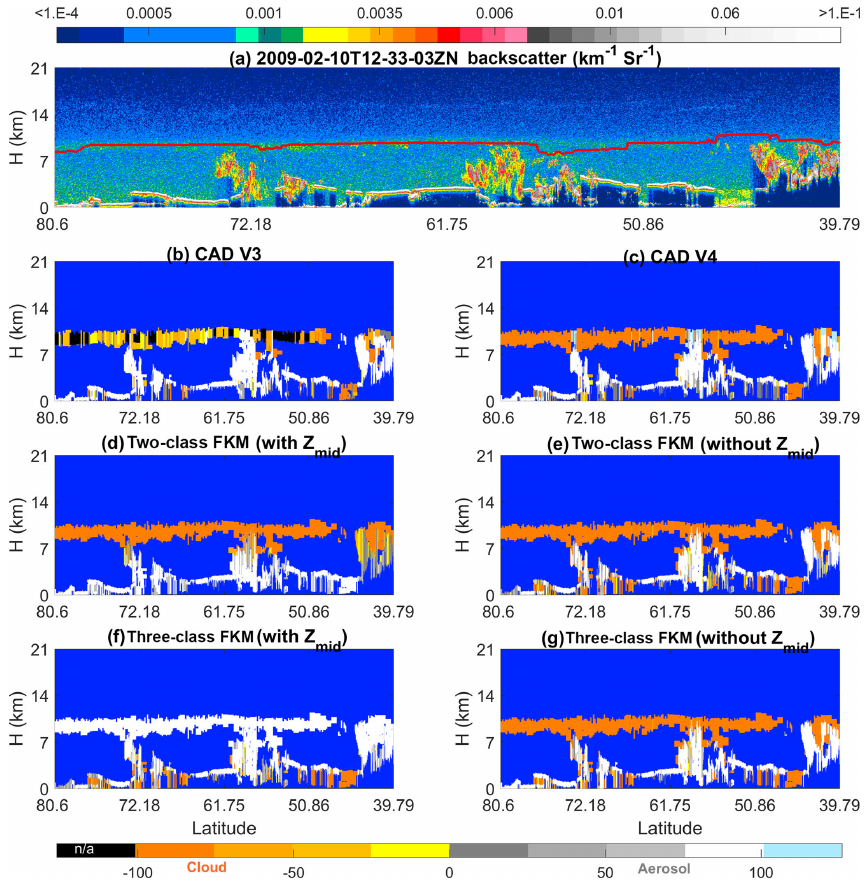
Figure 10. The top row shows 532nm attenuated backscatter coefficients for (a) measurements acquired on 5 October 2008 showing a layer of volcanic ash from the eruption of Kasatochi. The solid line extending across panel (f) at altitudes between ∼ 7 and ∼ 8 . 5km shows the approximate tropopause altitude. The rows below show the CAD results reported by six different algorithms: the V3 operational CAD (b) , the V4 operational CAD (c) , the two-class CAD FKM with z mid (d) and without z mid (e) , and the three-class CAD FKM with z mid (e) and without z mid (j)